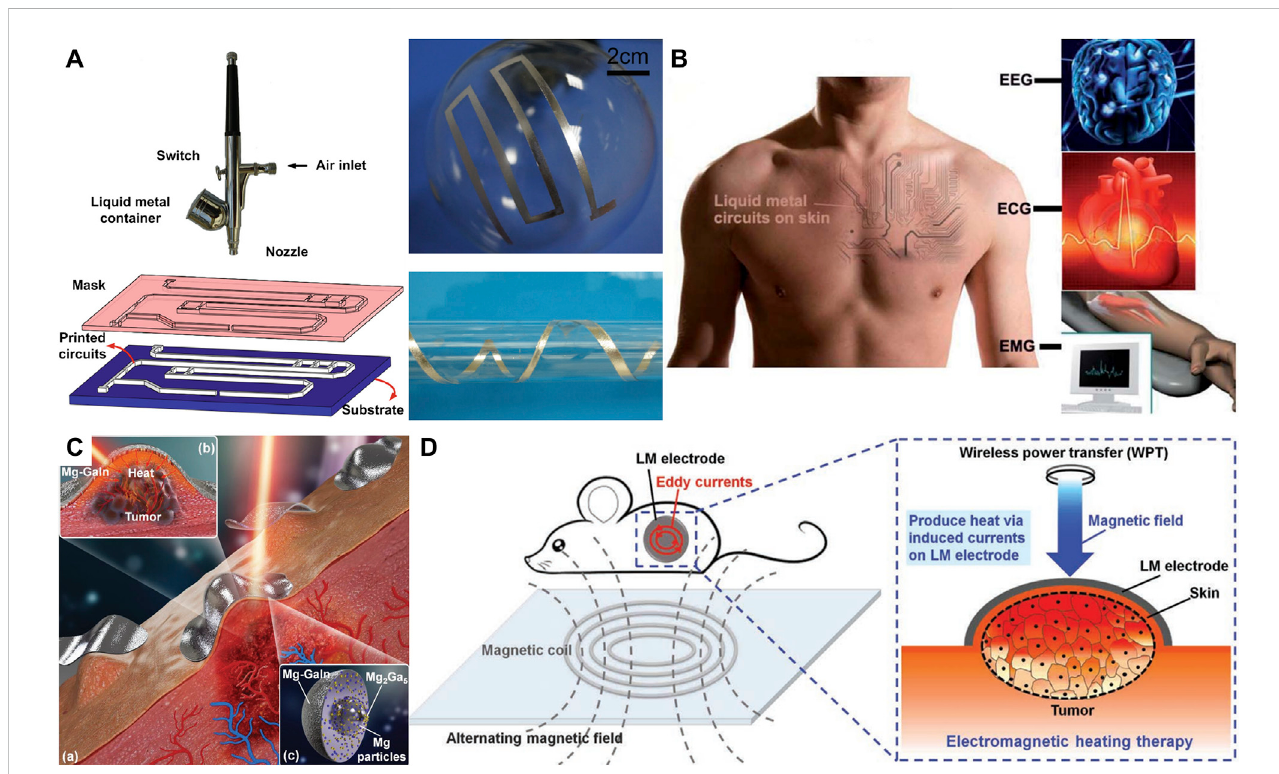
Methods of preparing LM circuits directly on the skin. (A) The schematic diagram of the rapid prototyping circuits based on atomized spraying of LM droplets(Zhangetal.,2014).Copyright@2014,Springer (B) SchematicconceptionoffabricatingLMcircuitsonhumanskin(Guoetal.,2014).Copyright@2014, RSC (C) The soft Mg-GaIn mixtures applied on skin – tumor surface (Wang et al., 2018d). Copyright@2018, Wiley (D) Schematic illustration of conformable O- 291 GaIn bioelectrodes on in vivo tumors (Wang et al., 2019). Copyright@2019,